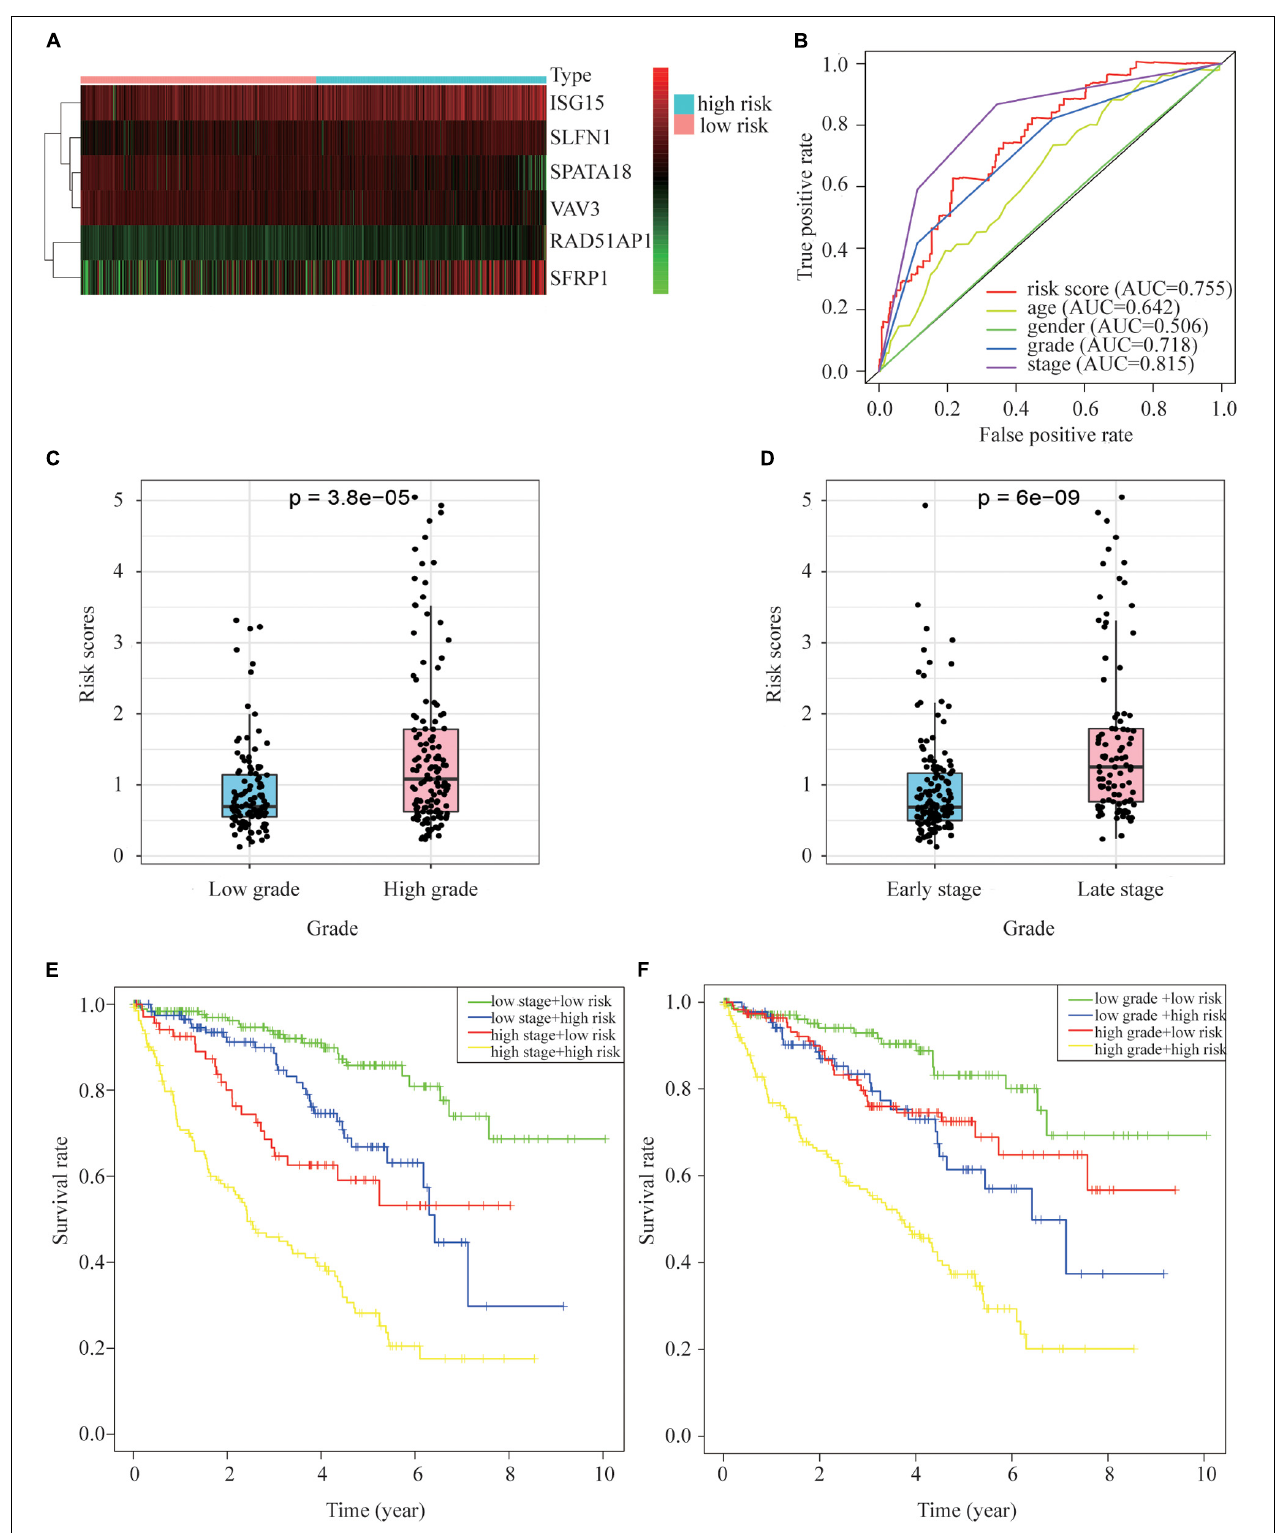
FIGURE 5 | Relationships between risk scores and clinical pathology indicators. (A) A heat map of gene expression in the different groups. (B) ROC relating risk scores with clinical indicators of pathology. (C) Tumor grade and risk score related. (D) Tumor stage and risk score related. (E) Overall survival curve for patients with different stages and risks. (F) Overall survival curve for patients with different grades and risks.